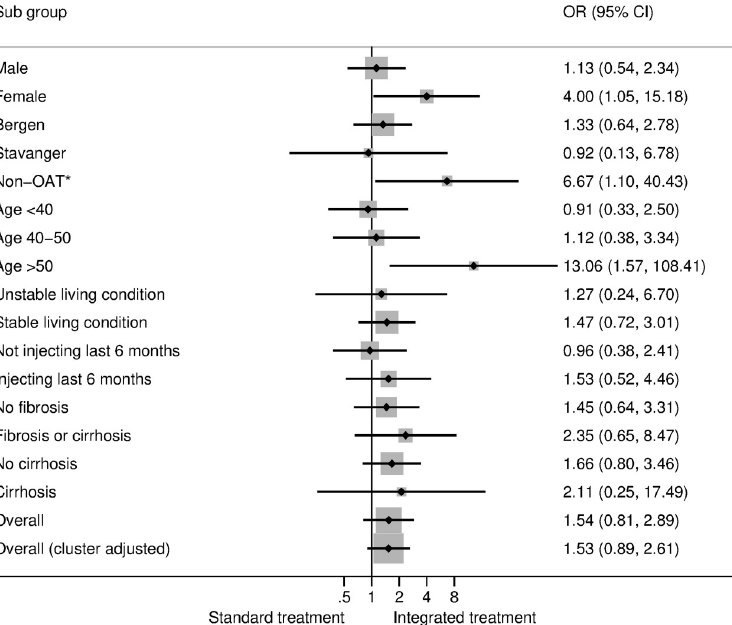
Fig 3. Subgroup analyses for binomial logit regression of SVR of hepatitis C for those who initiated treatment comparing the integrated arm with the standard arm (post hoc ITT analyses). Subgroup effects are presented for gender, the type of treatment center, age group, living condition, injecting drug use behavior the last 6 months, fibrosis and cirrhosis, and overall effects (without and with cluster adjustment) �� . � Non-OAT: patients who did not receive OAT. �� Interaction tests: sex: p = 0.069, site: p = 0.737, OAT/non-OAT: p = 0.095, age: p = 0.023, living condition: p = 0.367, injecting drugs: p = 0.309, fibrosis/cirrhosis: p = 0.605. ITT, intention-to-treat; OAT, opioid agonist therapy; OR, odds ratio; SVR, sustained virologic response.